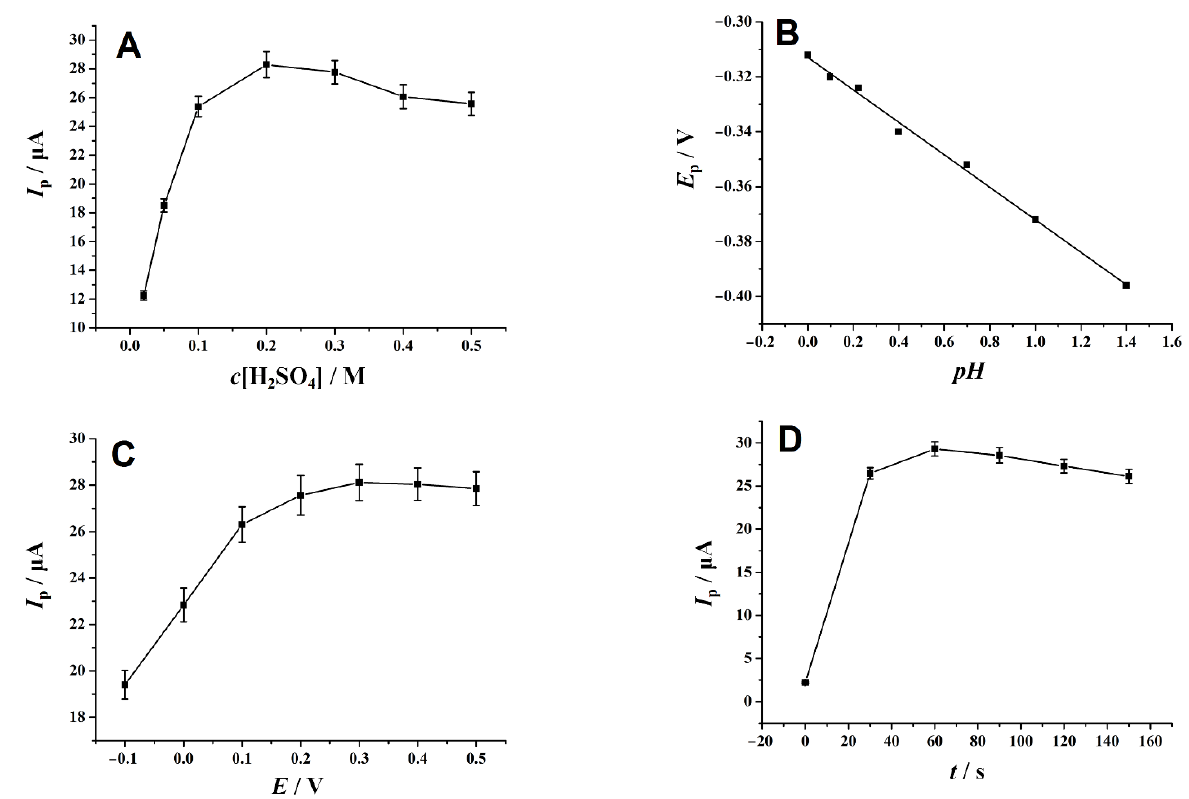
Figure 6. The optimum of experimental conditions: ( A ) the effect of H 2 SO 4 concentration on the peak current, ( B ) the effect of solution pH on the peak potential, ( C ) the effect of accumulation potential on the peak current and ( D ) the effect of accumulation time on the peak current. 4-NP concentration: 0.1 mM, scan rate: 0.1 V s −1 .